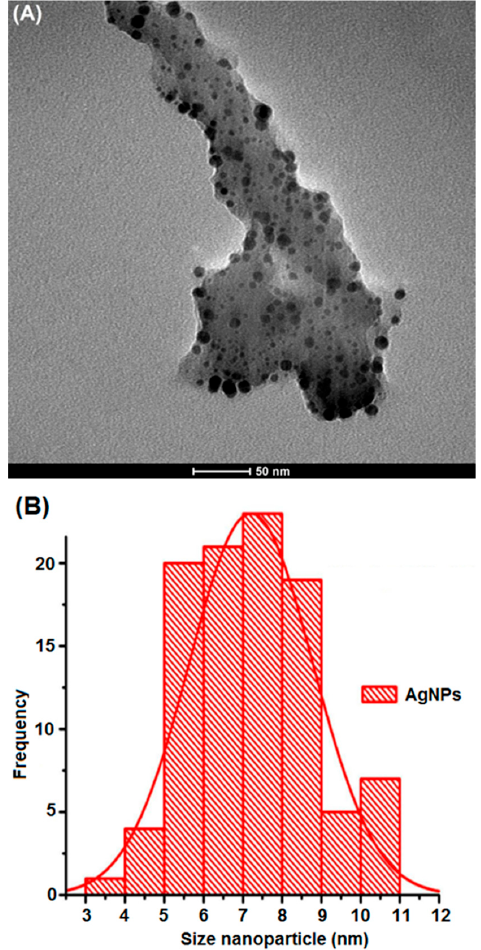
Figure 3. Ma AgNPs transmission electron microscopy (TEM) micrograph taken at 80 kV ( A ) and frequency histogram ( B